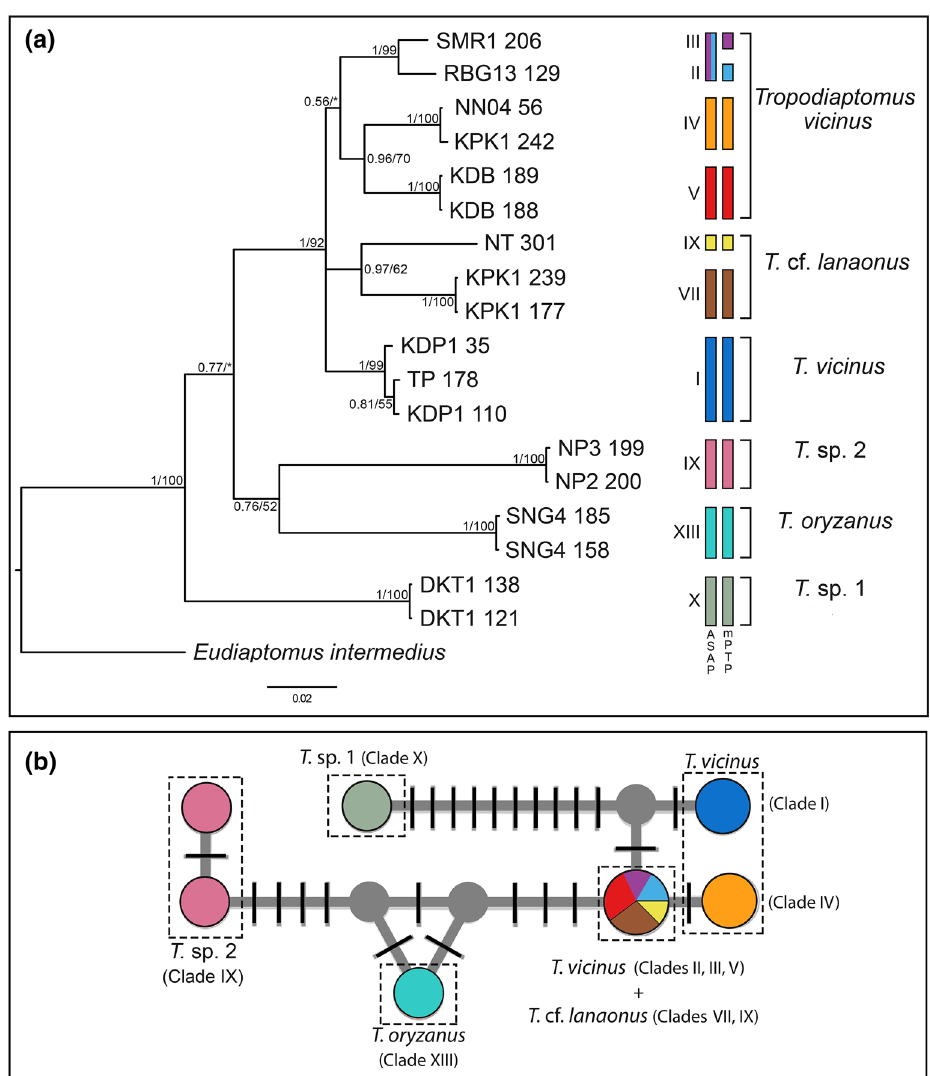
Figure 4. ( a ) Bayesian phylogram (95% majority rule consensus tree) of Tropodiaptomus spp. based on the concatenated 12S-ITS2-28S dataset. Eudiaptomus intermedius was used as an outgroup to root the tree. Node statistical support is reported as nodal posterior probabilities (Bayesian Inference of phylogeny, BI)/bootstrap values (maximum likelihood, ML). Asterisks indicate support values lower than 50. Rectangles refer to MOTUs as indicated by ASAP or mPTP (see Supplementary Figs. S2, S3). Square brackets group the samples according to their morphological identification. The analyzed specimens are reported using the location and codes listed in Table 1. ( b ) Median-joining haplotype network based on a fragment of the nuclear 28S ribosomal DNA. Dashes indicate substitution steps. Each circle represents a haplotype, and its size is proportional to its frequency. Dashed rectangles indicate the morphological identification of the specimens used in the analysis. Colours refer to the clades reported in ( a